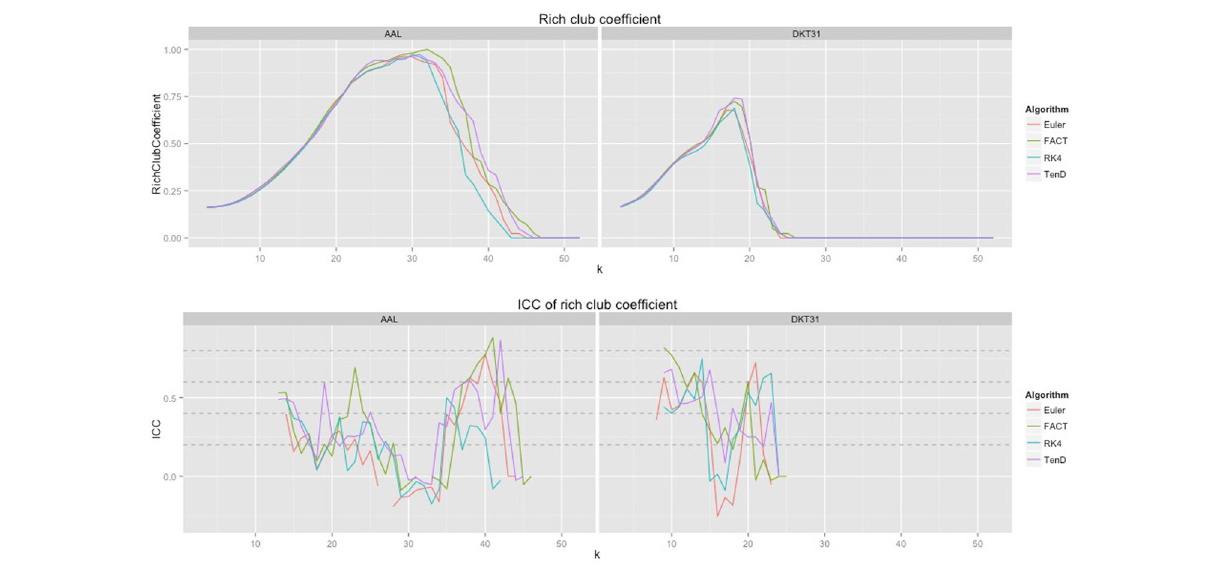
FIGURE 7 | Rich club coefficient was examined over a range of levels, k, and a constant graph density of